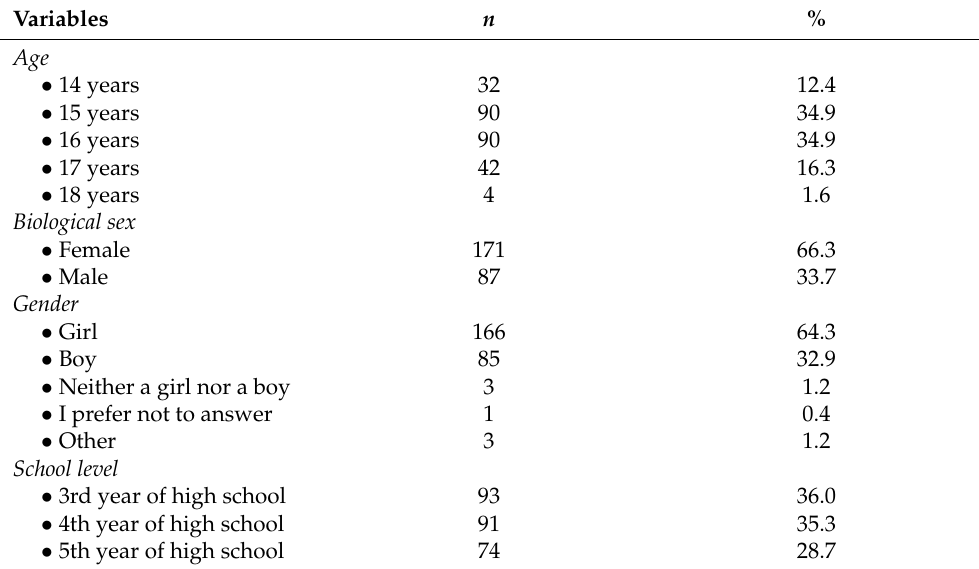
Table 1. Characteristics of participants ( n =